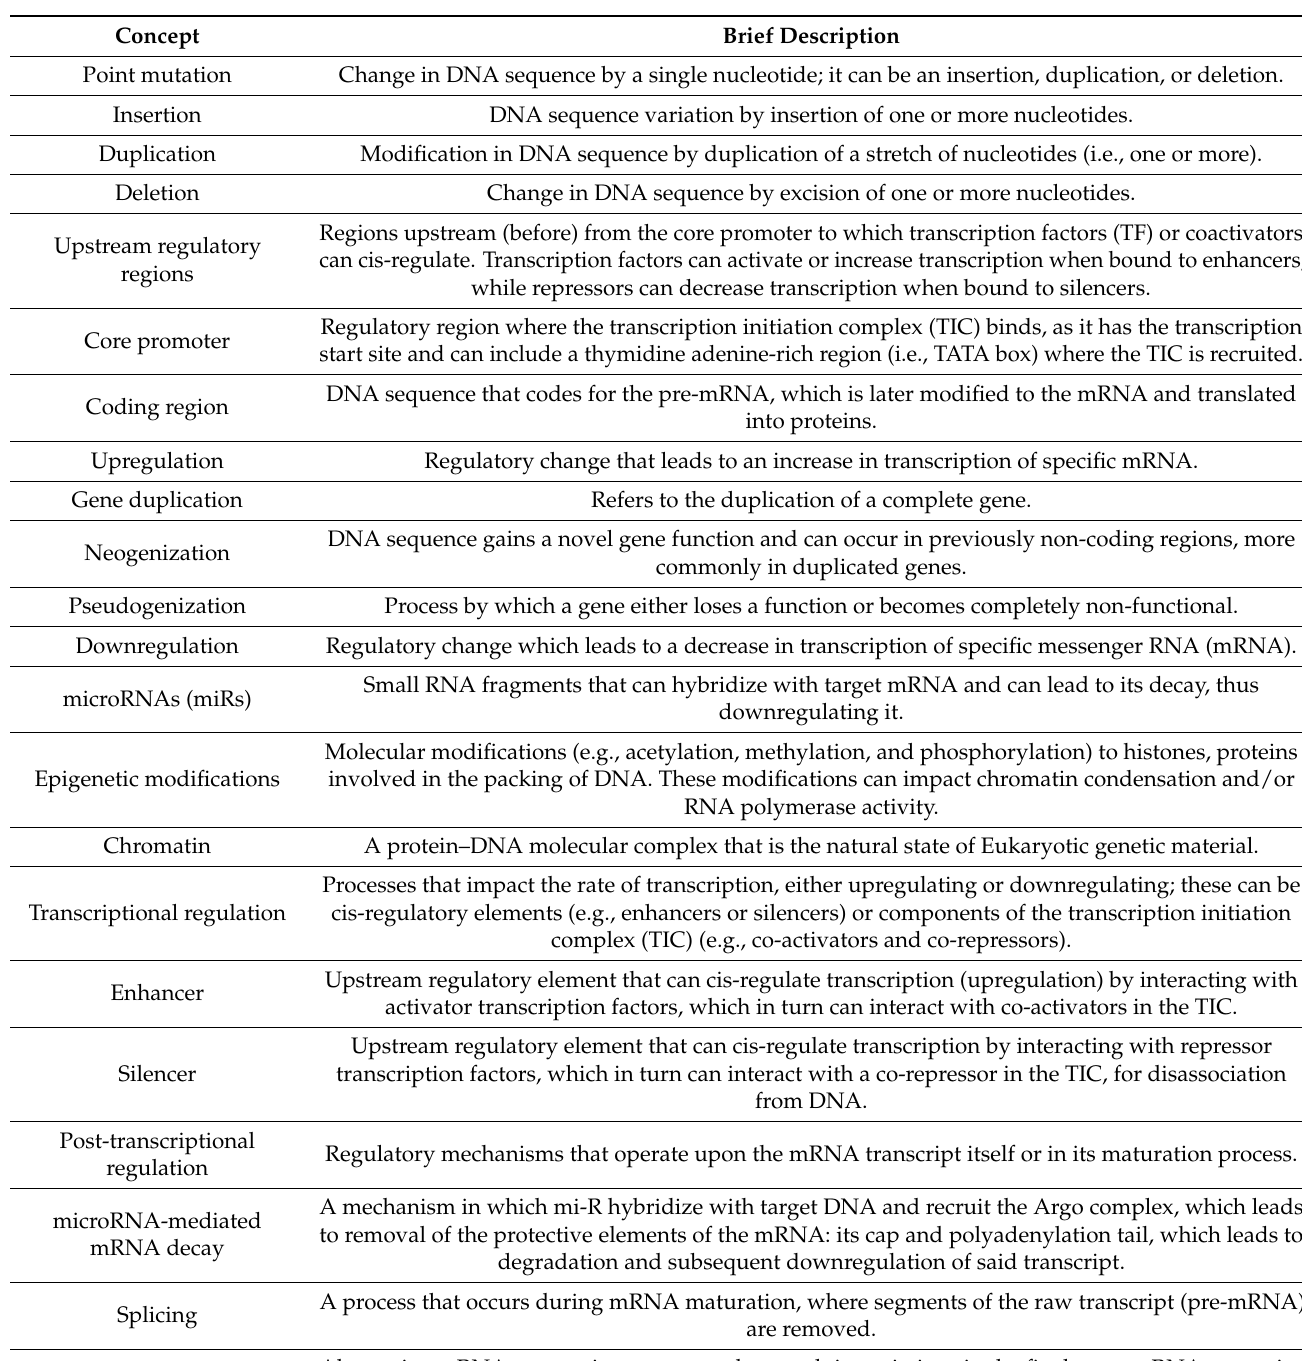
Table 1. Brief descriptions of the molecular mechanisms illustrated in Figure